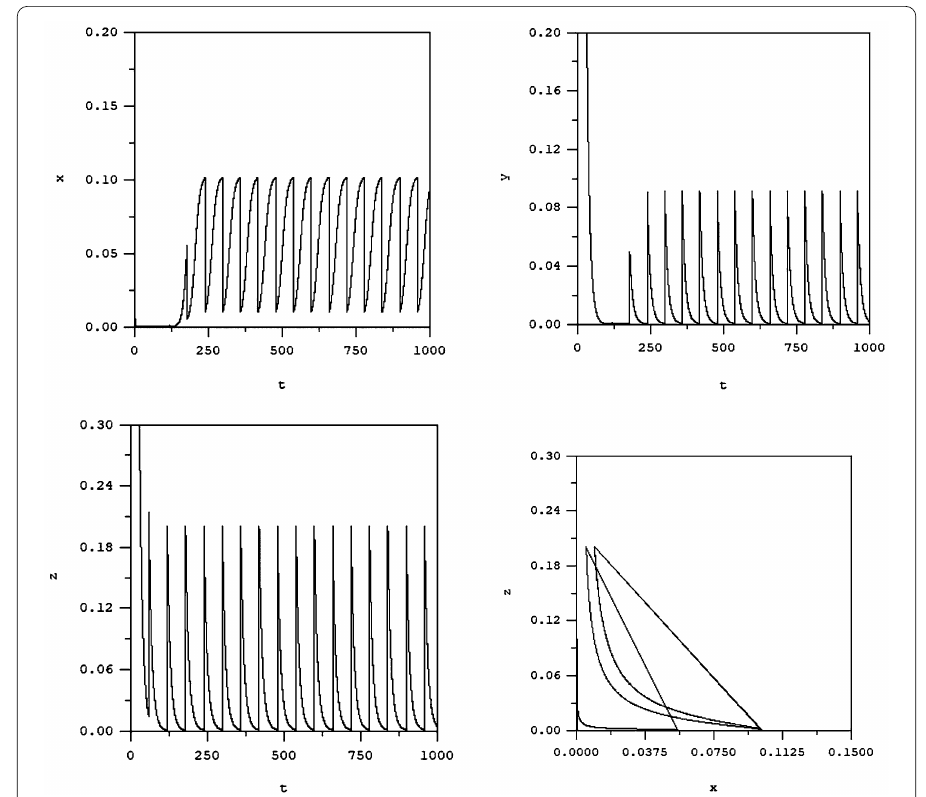
Figure 2 A computer simulation of the impulsive differential equations (1a)–(1f). The solution of the system is permanent. Here, a 1 = 0.38, a 2 = 0.1, a 3 = 0.247, b 1 = 0.25, b 2 = 0.1, b 3 = 0.1, k 1 = 0.3, k 2 = 0.017, α = 0.5, γ = 0.9, δ = 0.2, T = 60, x (0) = 5, y (0) = 5, and z (0) = 5 in which all conditions in Theorem 2 are